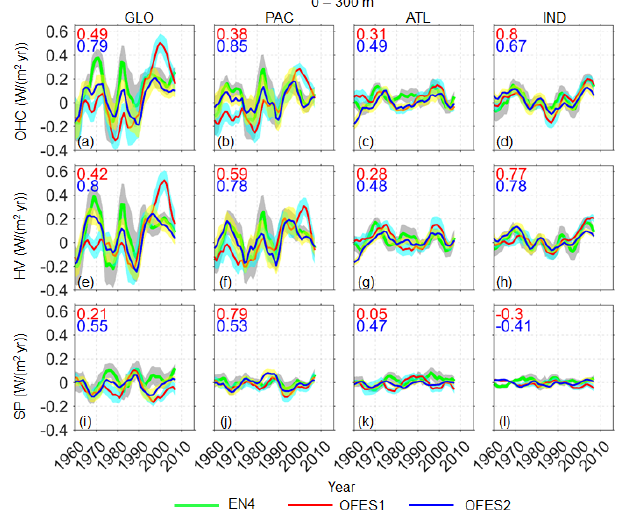
Figure 6. As for Fig. 5 but for the middle layer